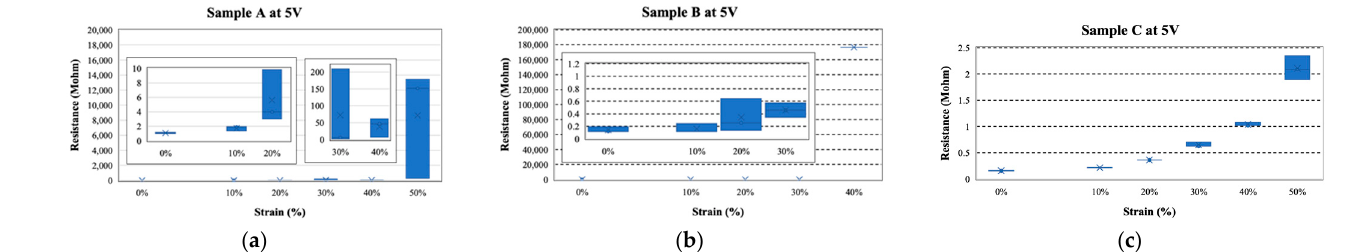
Figure 8. Resistance vs. strain of Sample A − C: ( a ) Sample A (Insets show magnified view due to large resistance differences), ( b ) Sample B (the inset shows a magnified view), and ( c ) Sample C showing distinguishable classification of the strain.